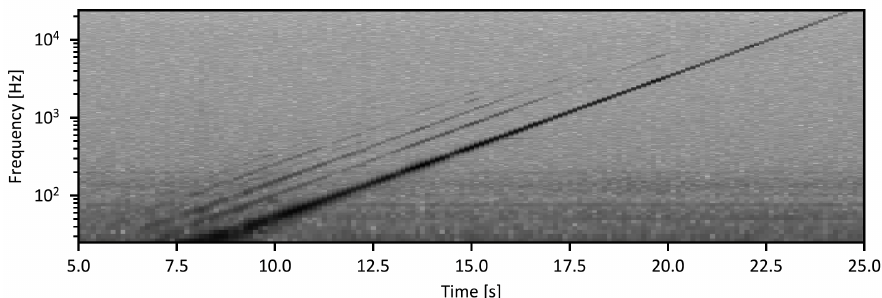
Figure 6. Spectrogram of an exemplary output of one of the array microphones. Harmonic distortions of several orders are